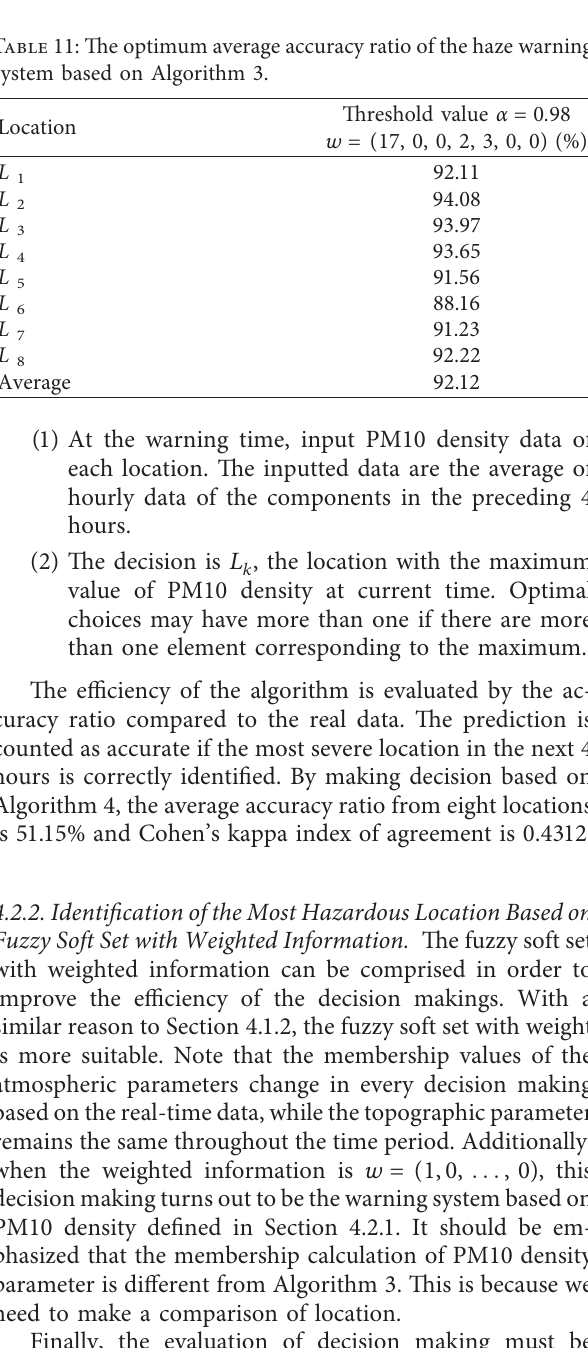
Algorithm 4. Identification of the most hazardous location based on PM10 density